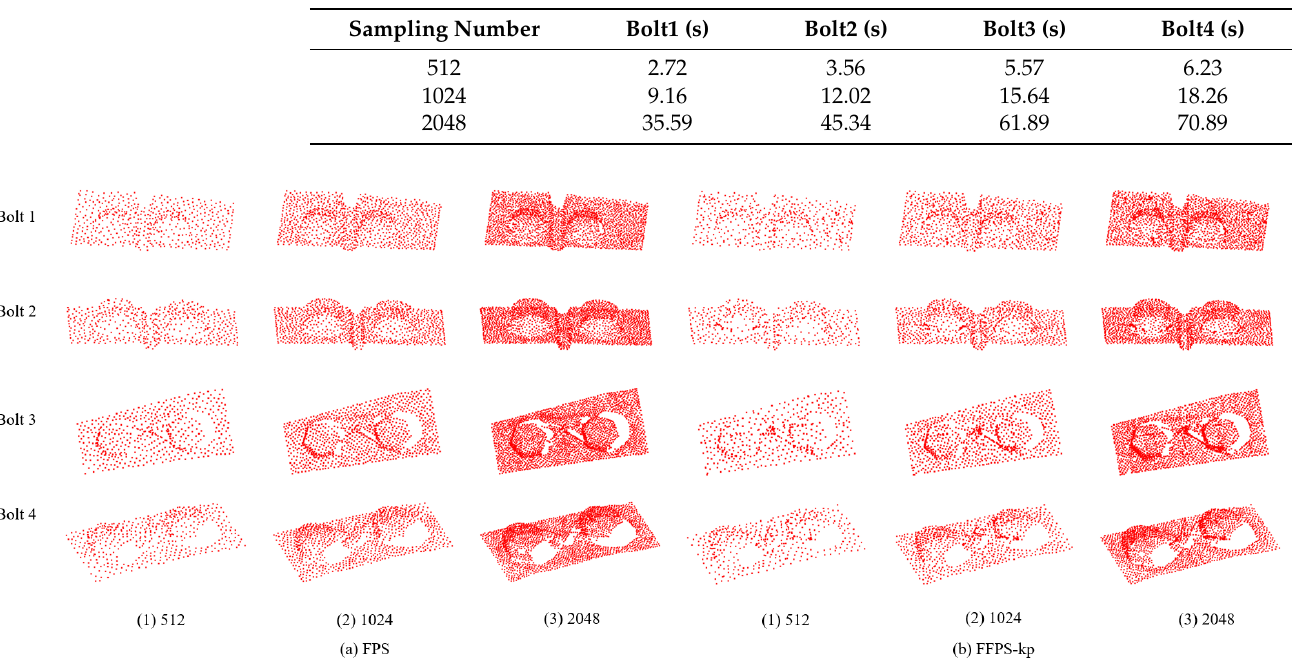
Table 5. FFPS-kp sampling time.